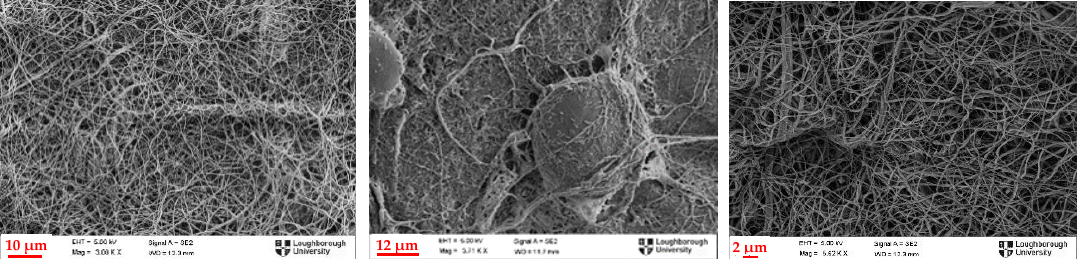
Figure A4. SEM images 1:1 PANI/CS membranes on day 1 after seeding with human osteoblasts.